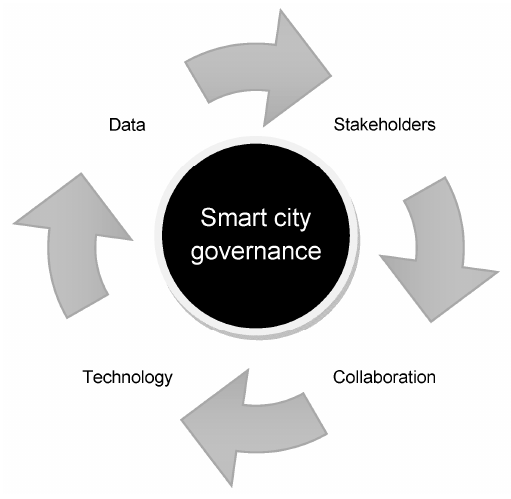
Figure 1. Key pillars of smart city